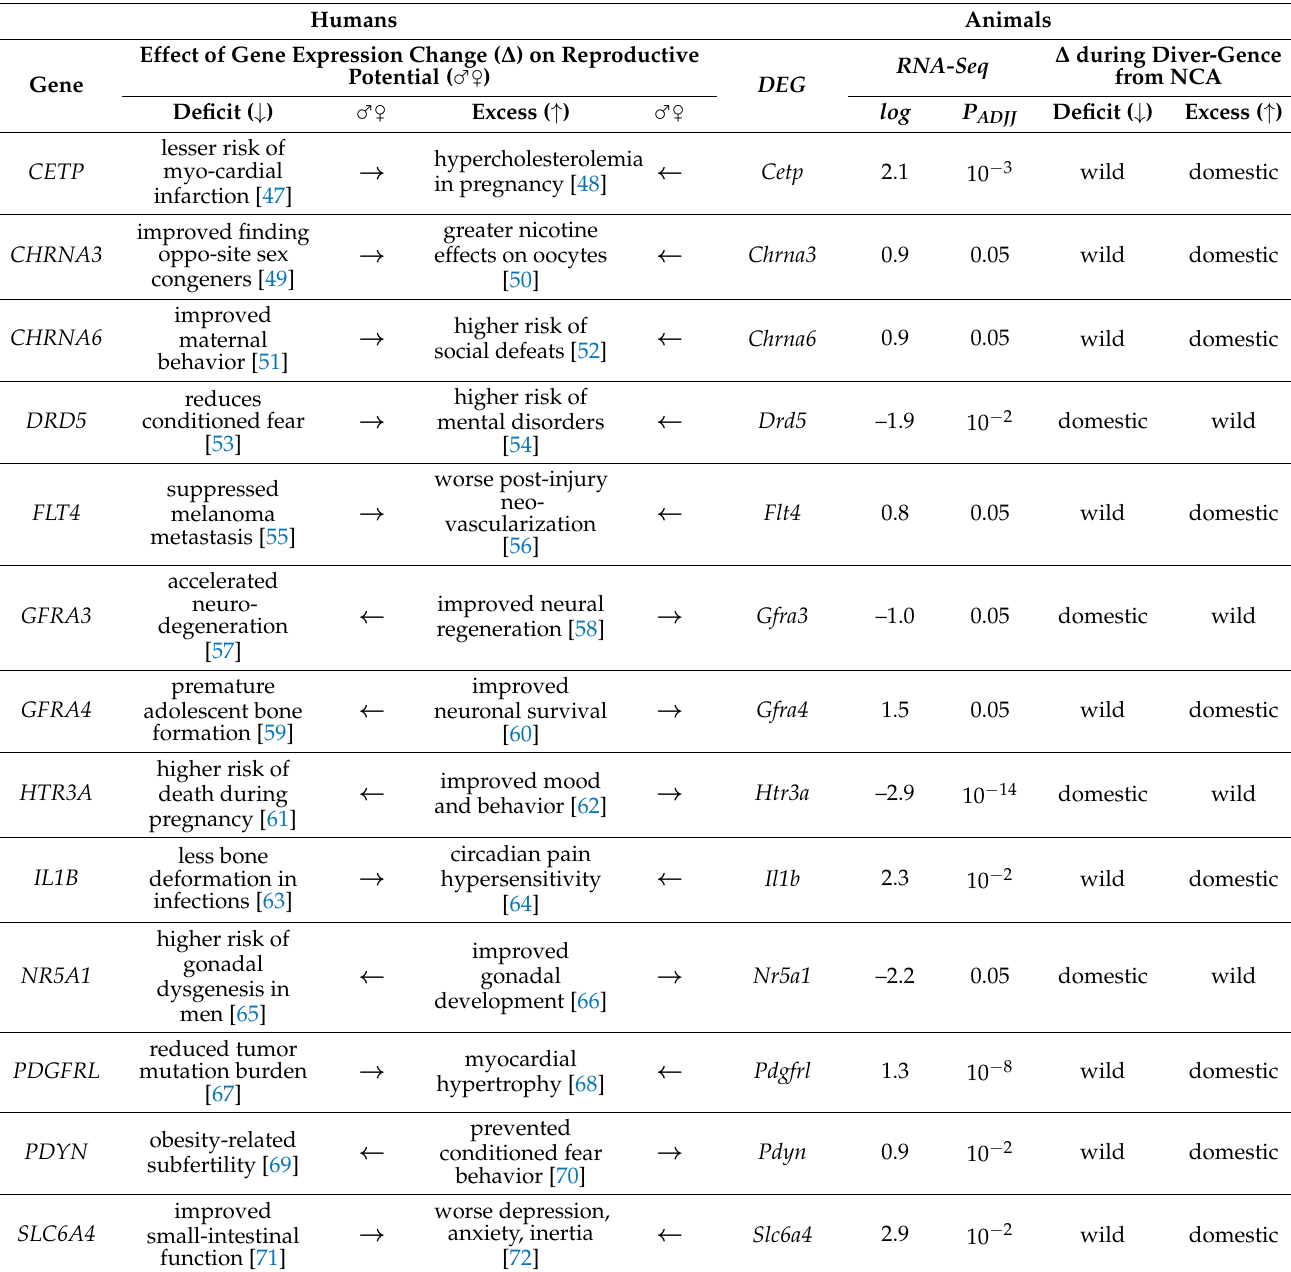
Table 2. Comparing the effects of changes in the expression of orthologous genes on human reproductive potential and on the divergence of the guinea pig and cavy from their nearest common ancestor (NCA)